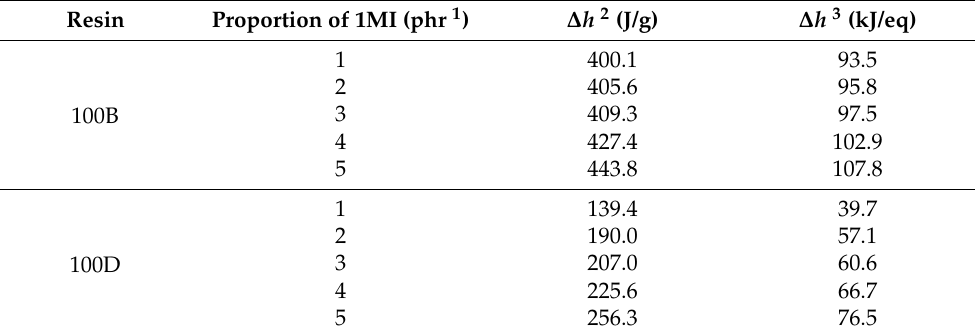
Table 2. Calorimetric data of the curing of epoxidized linseed oil (ELO) with benzene-1,3-dithiol (1,3BDT) and pentaerytritol tetrakis (3-mercaptopropionate) (PETMP) containing different amounts of 1-methylimidazole (1MI).